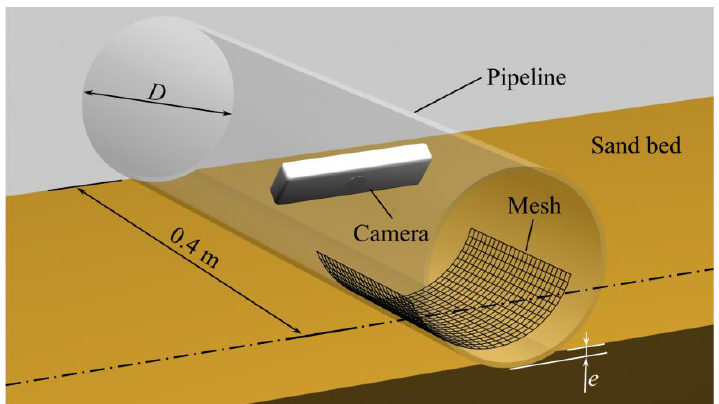
Figure 3. Three-dimensional diagram of the model pipeline.